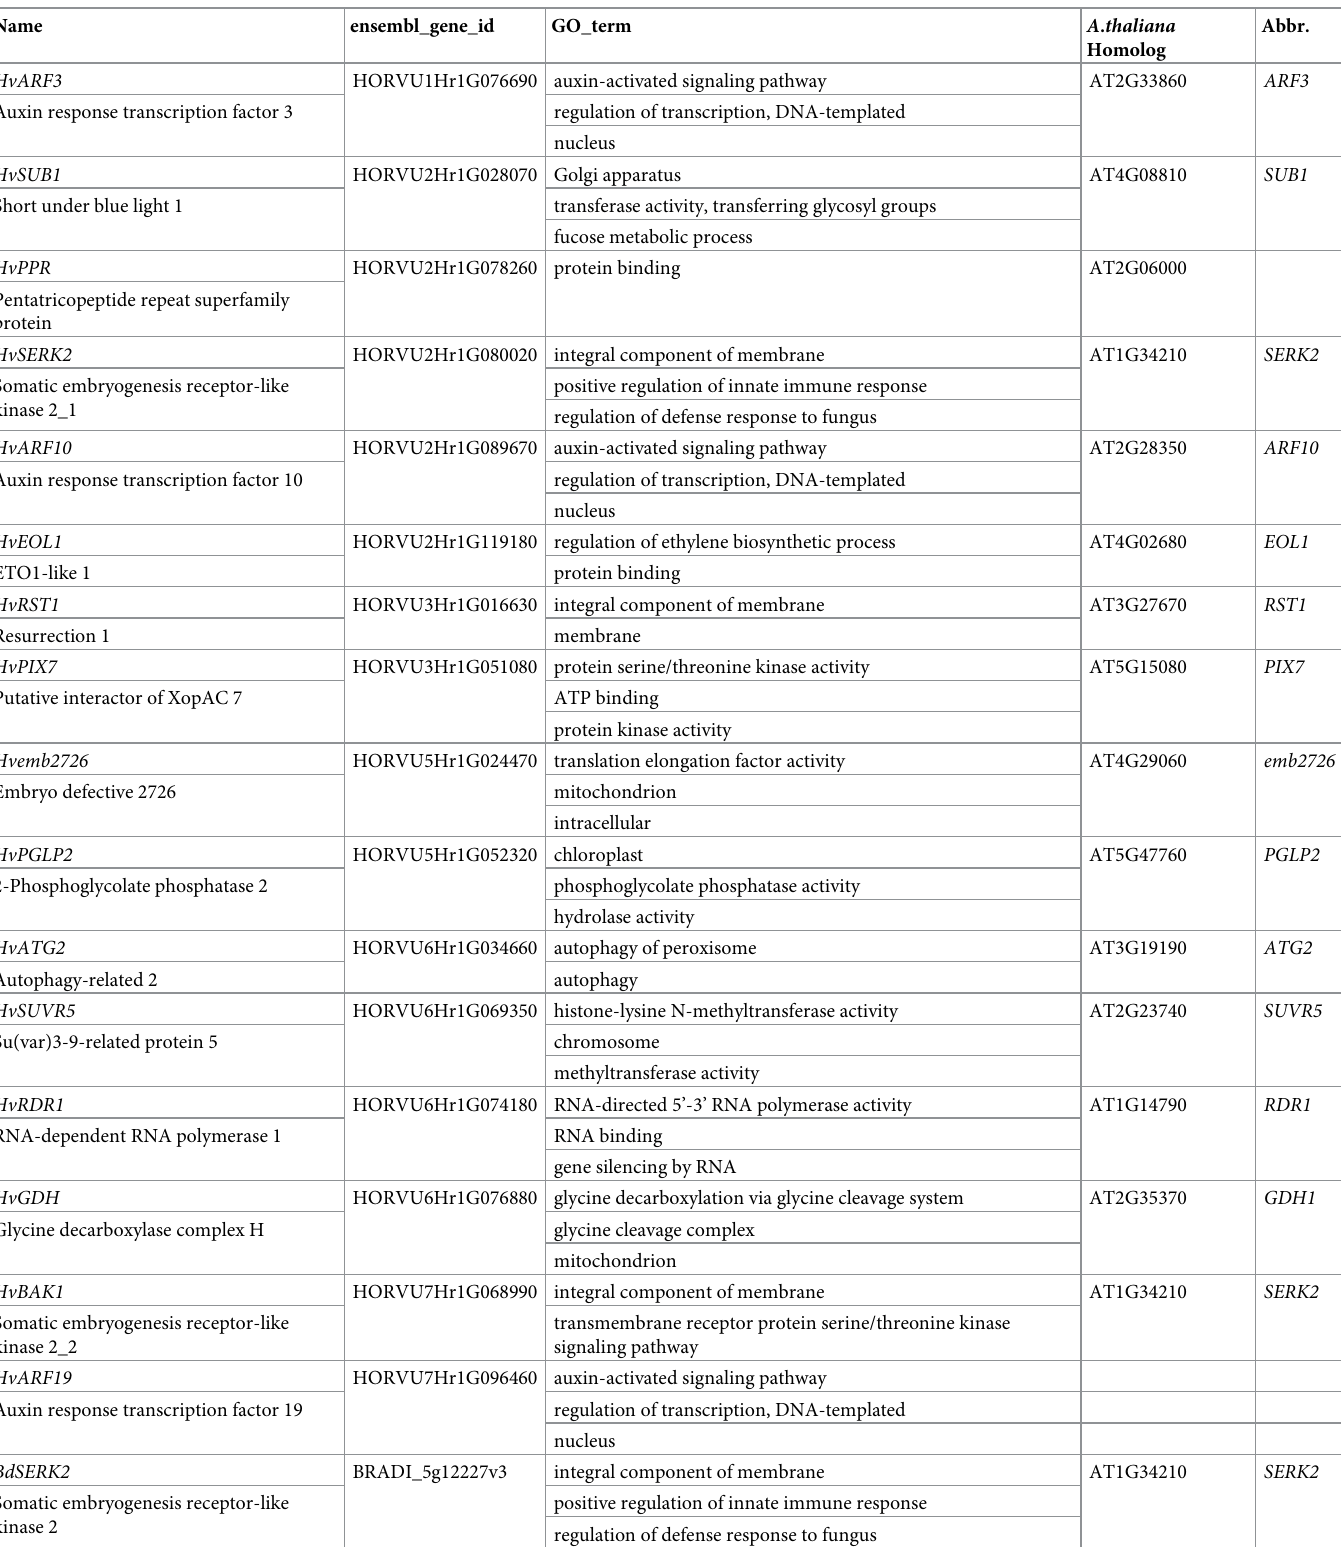
Table 1. Selected GO-terms of tested genes and closest homologs in A . thaliana .